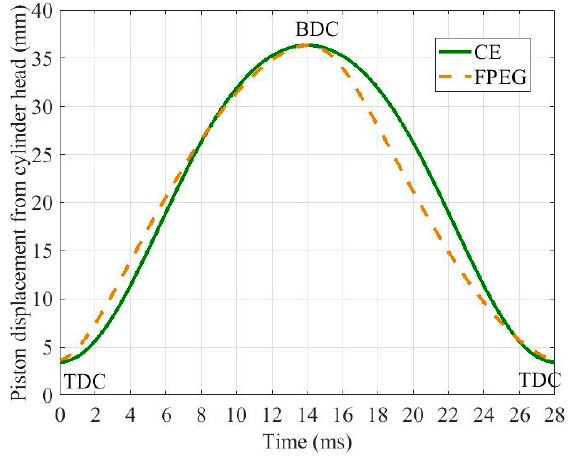
Figure 3. Comparison of FPE and CE piston displacement.